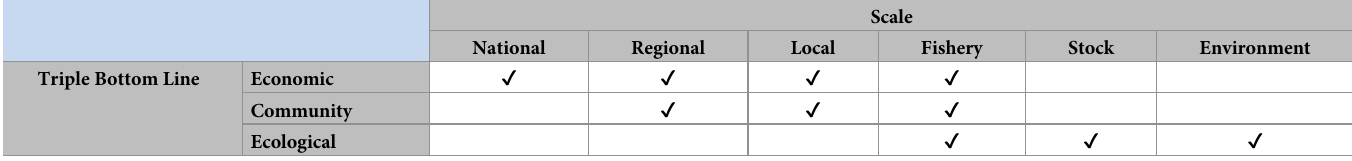
Table 1. Meaningful scales of measuring performance outcomes.